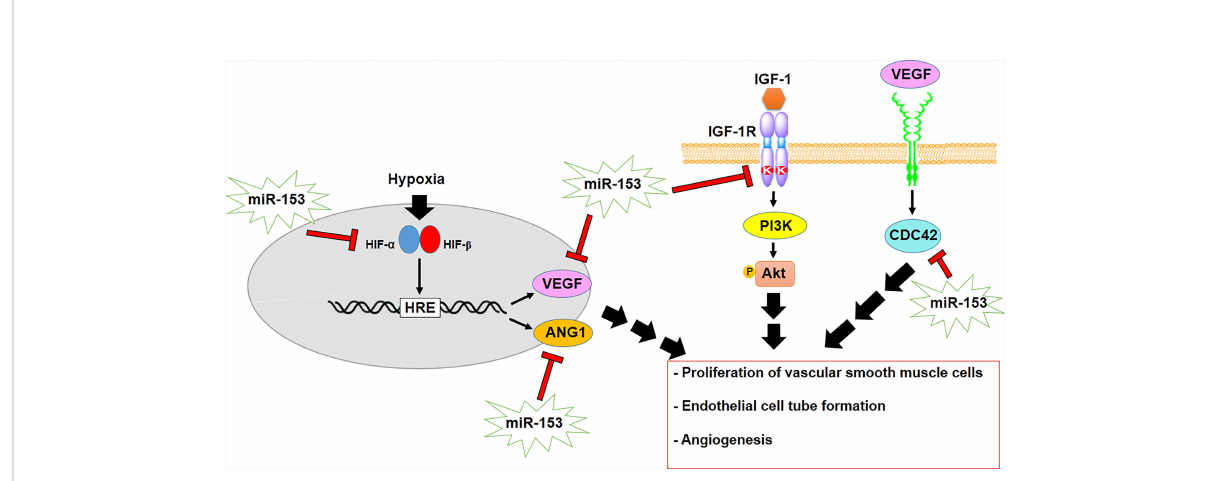
FIGURE 3 miR-153 regulates angiogenesis and proliferation of VSMCs by modulating HIF1 a /VEGF/CDC42 axis as well as inhibiting PI3K/Akt